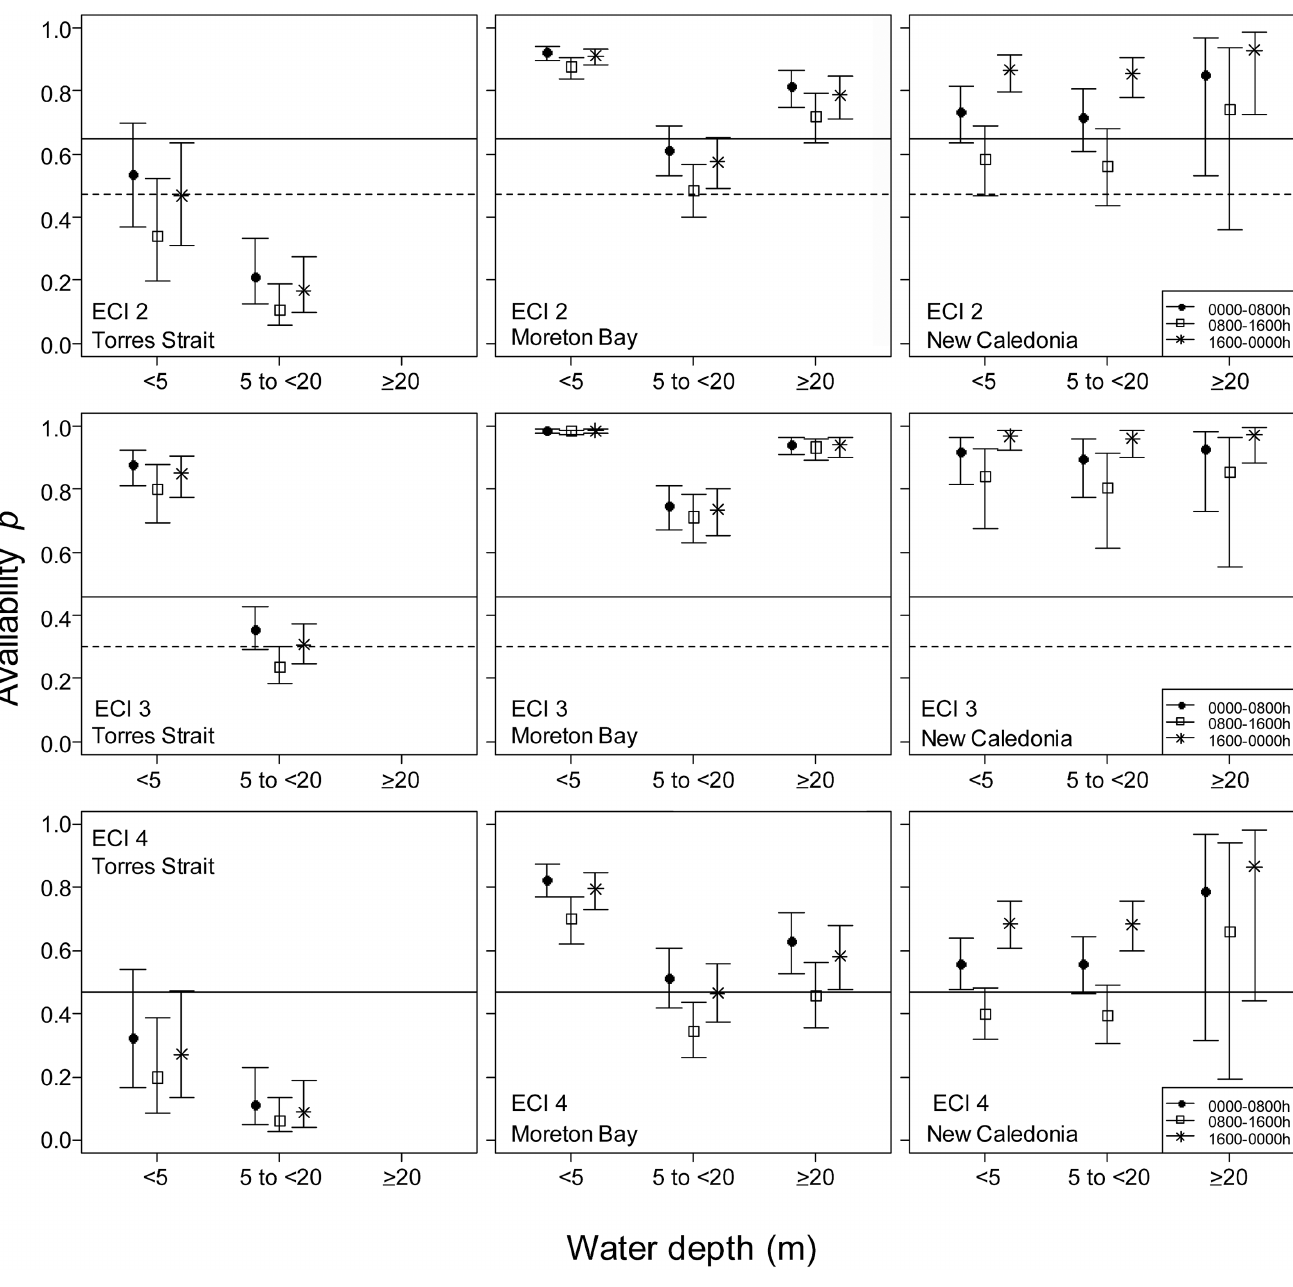
Fig 2. Availability detection probability estimates at the three locations, three time periods, three depth categories and three levels of environmental conditions index (ECI2-4). The horizontal lines represent the availability detection probabilities from Pollock et al. [18] for three turbidity levels and sea states (solid lines = optimal sea state; dotted lines = marginal sea state). Note in this study turbidity levels and sea state were merged to give a composite index ECI. The dotted lines in ECI4 are invisible as they overlap with the solid